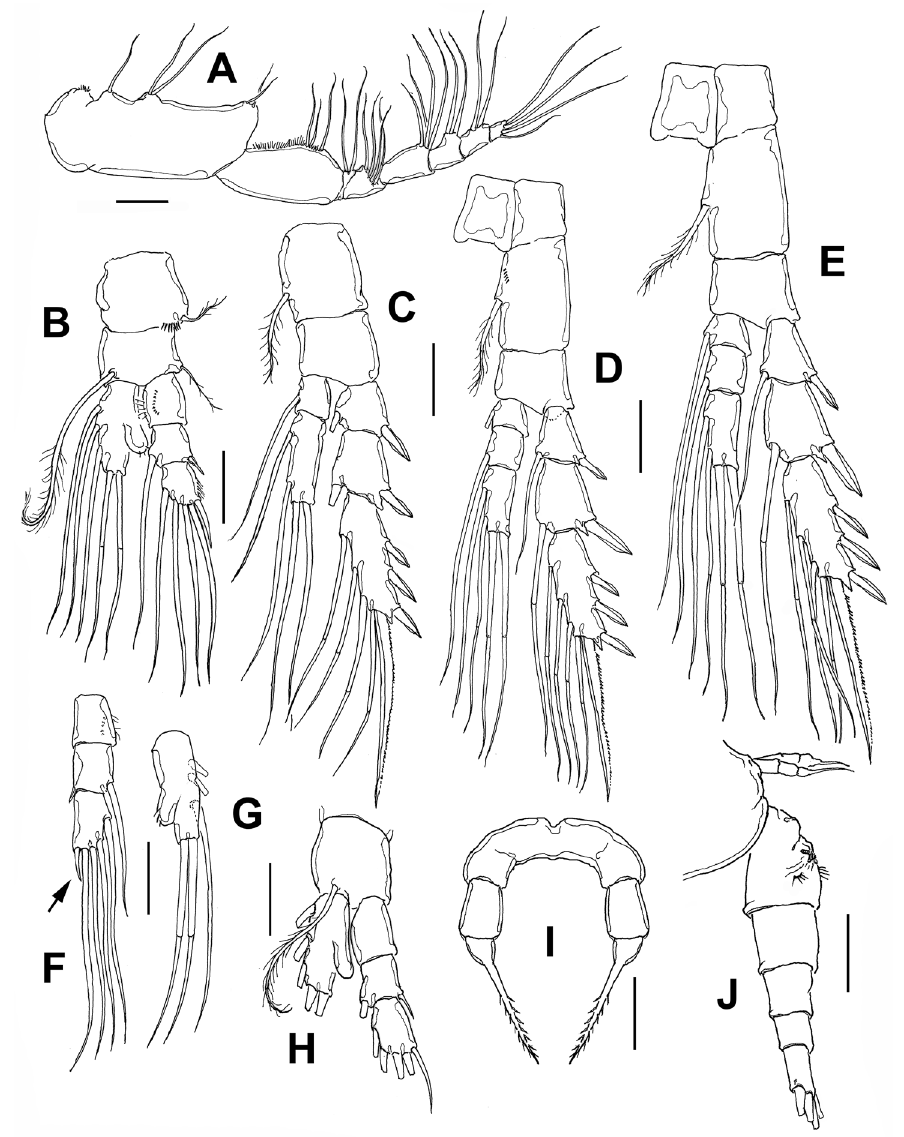
Figure 2. Stephos fernandoi sp. n., adult female from Cozumel, Mexico. A maxilliped B leg 1 C leg 2 D leg 3 E leg 4 F leg 1 exopod, another specimen showing reduced outermost apical spine (arrow) G leg 1 endopod, another specimen H male leg 1 I female leg 5, anterior view J fifth pedigerous somite and urosome, lateral view. Scale bars: A–I 20 µm; J 50